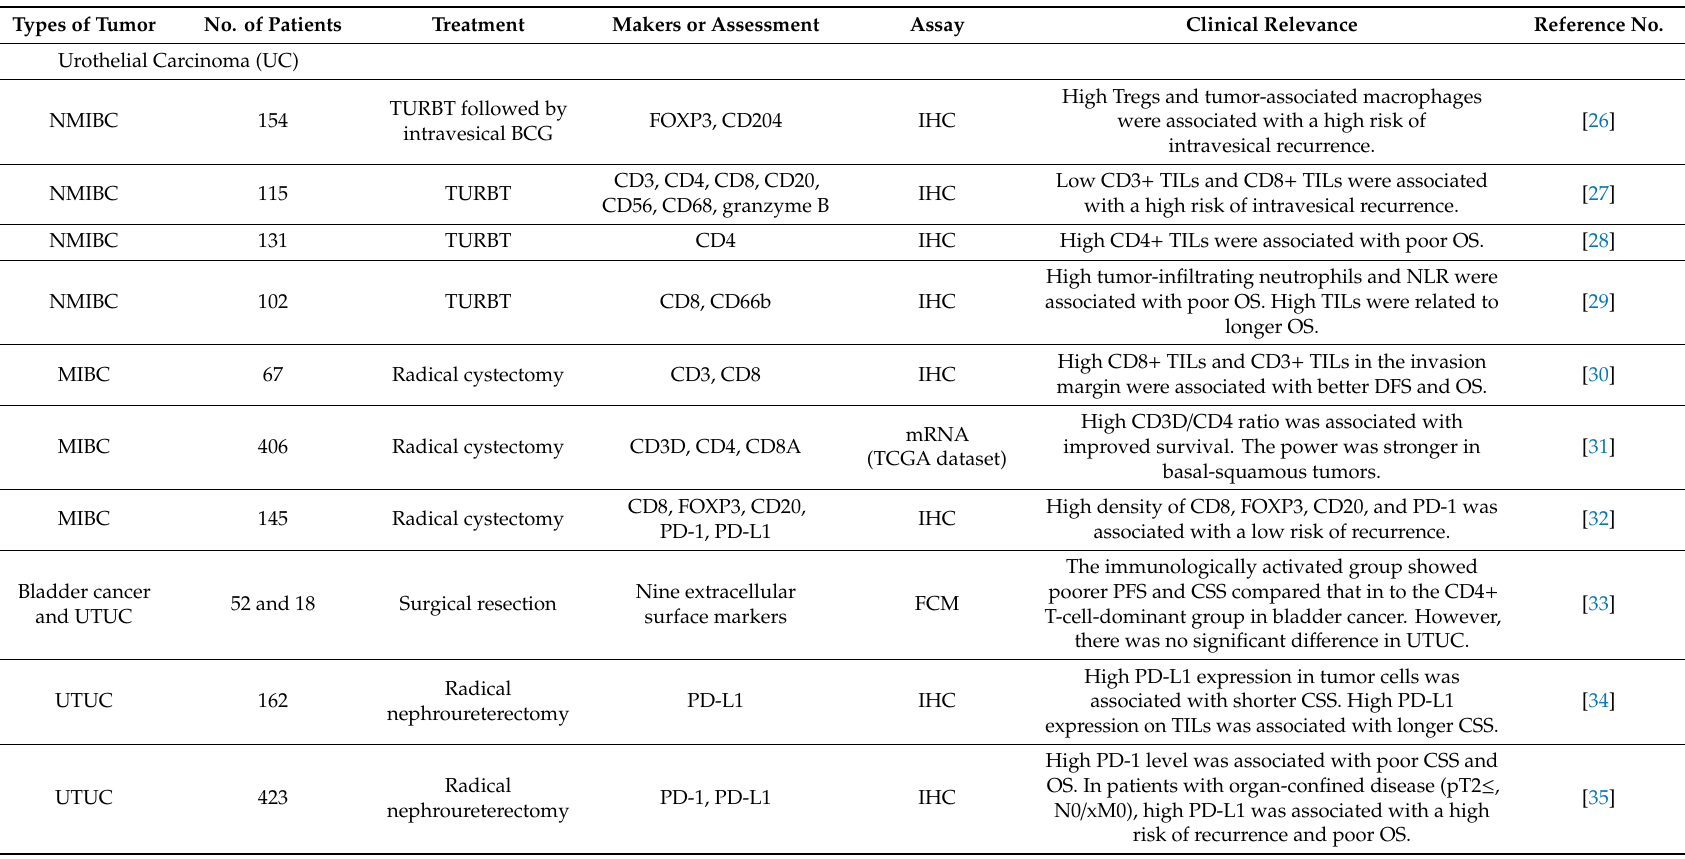
Table 1. Studies for the clinical relevance of tumor-infiltrating lymphocytes (TILs) in urological malignancies and retroperitoneal sarcoma. Types of